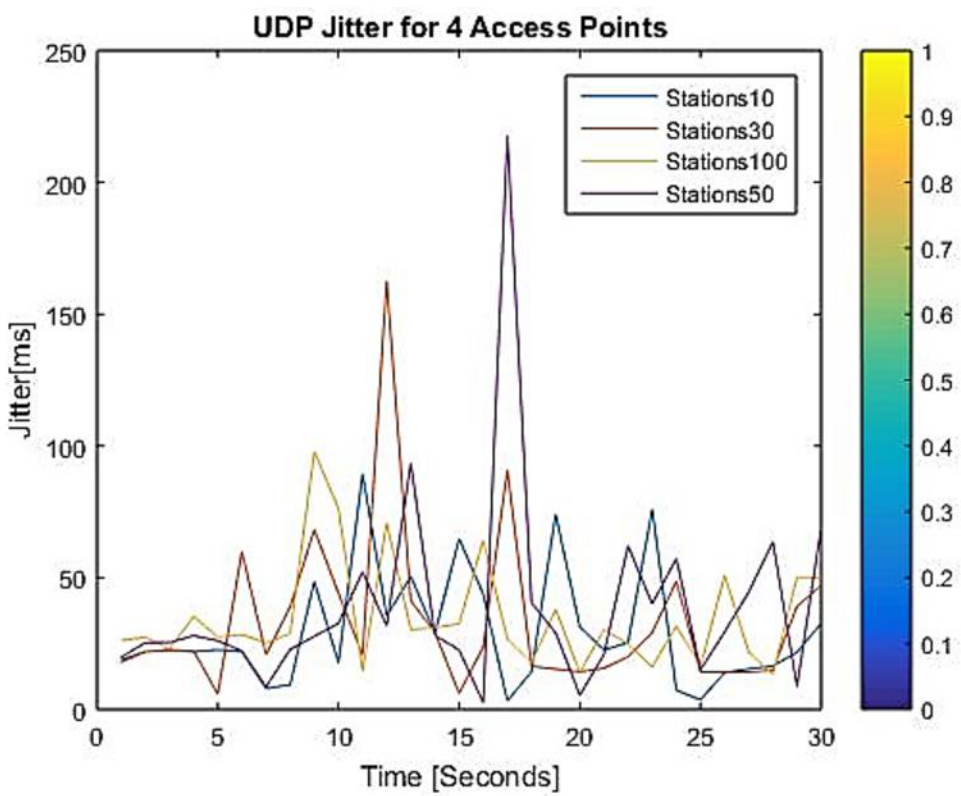
Figure 17. UDP jitter for 4 access points.